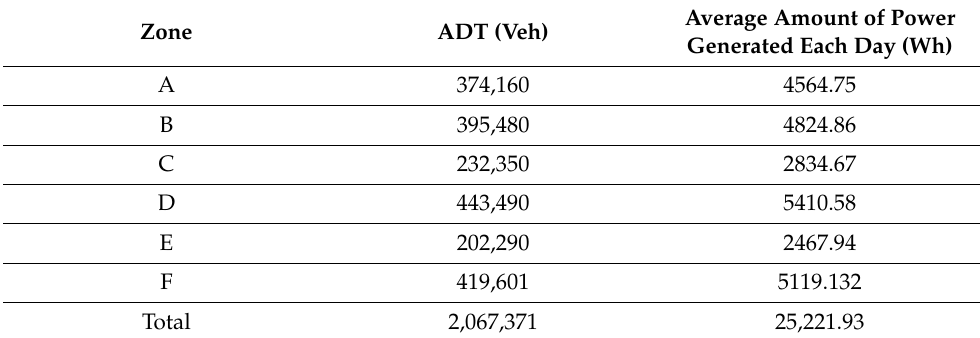
Table 6. Expected total amount of electricity generated each day from all